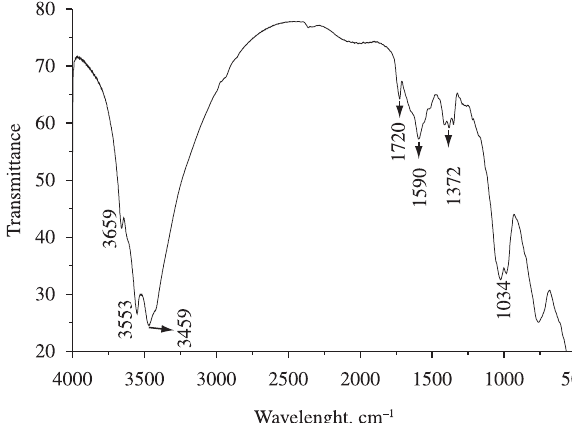
Figure 7. FTIR of the NTCDA-bayerite.